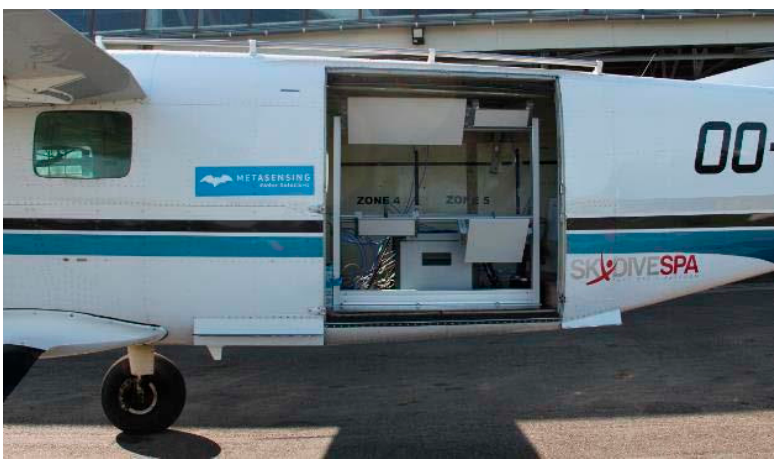
Figure 3. Cessna C208 carrying the SARSense radar setup. The top left and bottom right antennas are for L-band, the bottom left and top right antennas for C-band. Table 2. Description of the SARSense C- and L-band radar system.